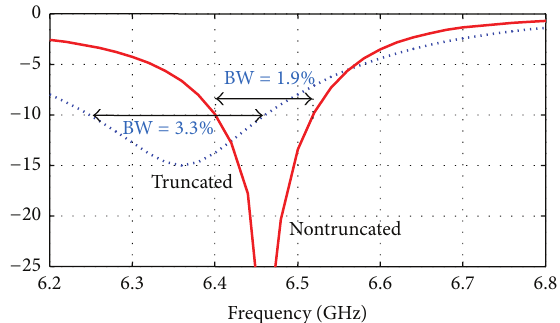
Figure 9: Simulated | S 11 | (dB), calculated at the waveport of the coaxial cable; truncated antenna in Figure 7 is compared with the nontruncated version in Figure 4(a); there is ∼ 1.8% drop in resonance, owing to